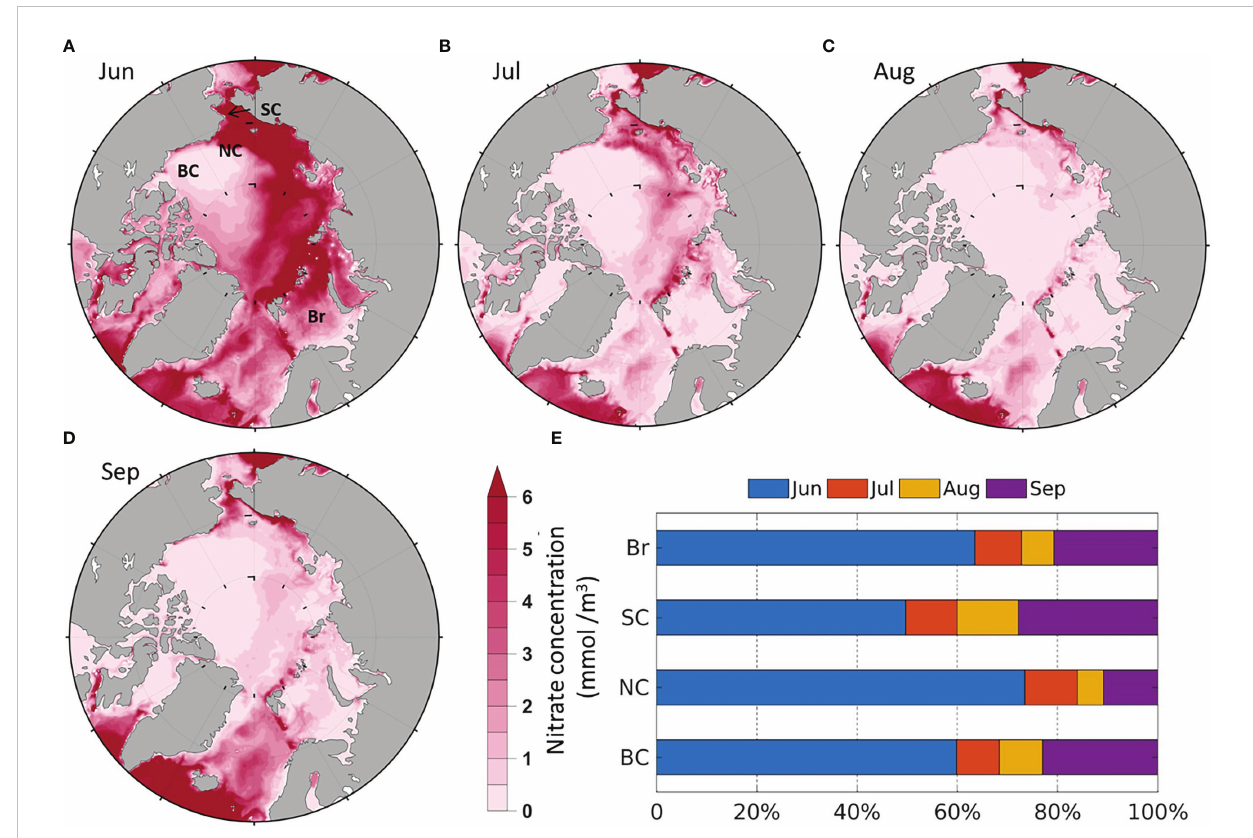
FIGURE 4 Modeled average monthly surface (0-20m) NO 3 (1990-2014) in (A) June; (B) July; (C) August; (D) September; (E) Average percentage of monthly contribution to summer NO